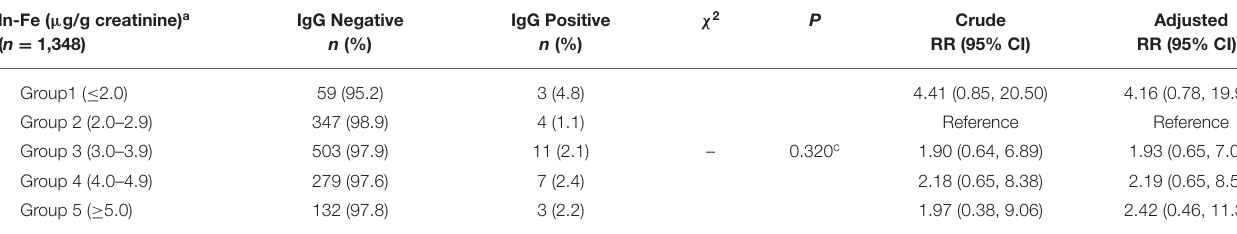
TABLE 3 | Associations (RR, 95% CI) between urine Ln-Fe concentration and positive IgG antibody of DENV in pregnant